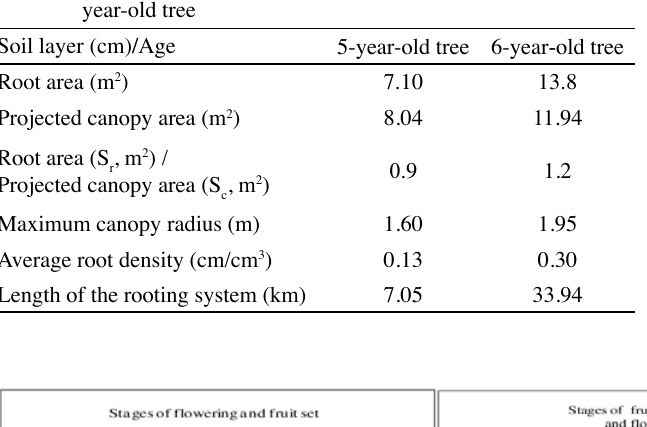
development.Fig. 7 - Average root densities (cm/cm 3 ) recorded for five- and six-year-old olive trees at 0.40, 0.80, and 1.20 m distance from trunks. Mea- Table 5 - Characteristics of the rooting system of the six-year-old-tree of cultivar Chétoui compared with those recorded for a